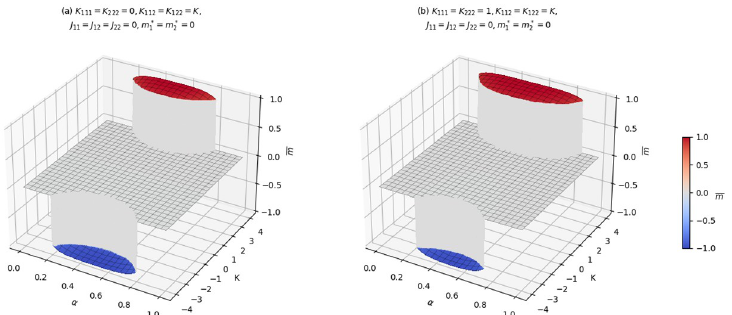
Fig 4. Average opinion for K 111 = K 222 = 0 and K 111 = K 222 = 1 with K 112 = K 122 = K varying. In the left panel, panel (a) , the cubic in-group interaction for the AI agents and that of humans are set to zero (i.e. K 111 = K 222 = 0) and in (b) to one (i.e. K 111 = K 222 = 1) with varying inter-group